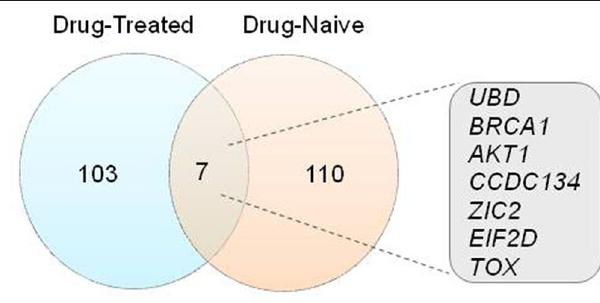
FIGURE 3 | Comparative gene expression analysis. Visual representation of the relationship between 227 DEGs from microarray studies using Venn diagram analysis.